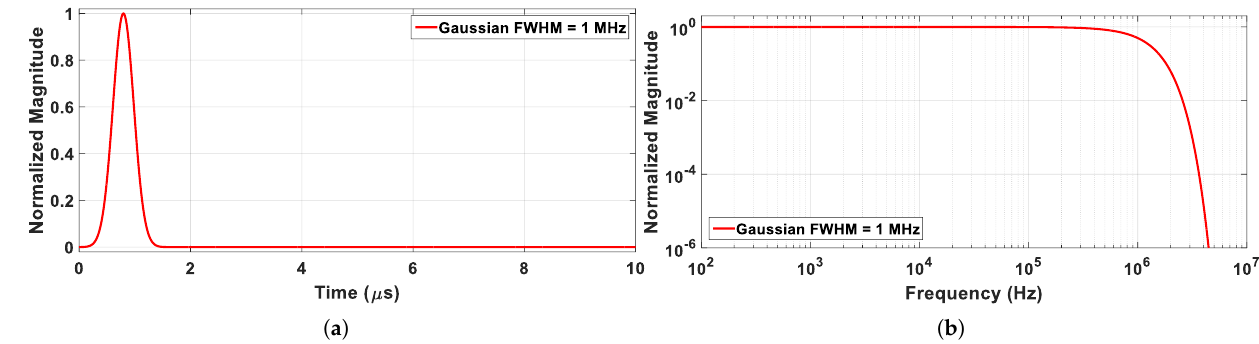
Figure 4. Lightning current modeled as a Gaussian pulse: ( a ) Time-domain normalized waveform and ( b ) Frequency-domain normalized